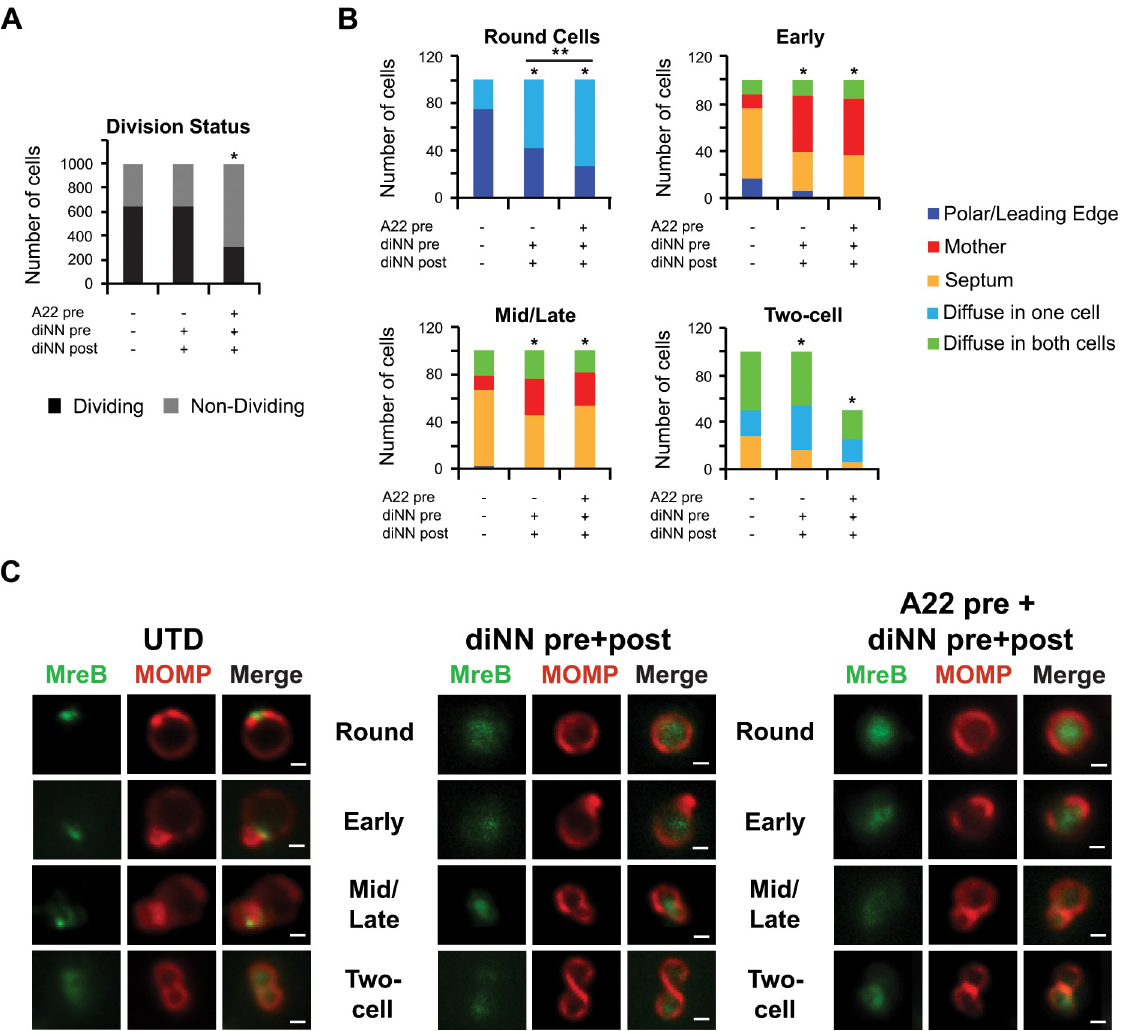
Fig 7. Effect of the CL-targeting antibiotic 3’,6-dinonylneamine (diNN) and the MreB-targeting antibiotic A22 on localization of MreB_6xH. HeLa cells were infected with the MreB_6xH transformant, and, at 22hpi, infected cells were lysed and chlamydial cells in the lysate were induced by incubating the cells in axenic media containing 10nM aTc. In some instances, cells were preincubated with 5 μ M diNN or 5 μ M diNN + 75 μ M A22 for 30 minutes and then induced with aTc in the presence of 5 μ M diNN alone. Following induction, the localization of MreB_6xH at various stages of division was assessed by staining cells with MOMP and 6xHis antibodies. (A) The total number of dividing versus non-dividing cells from the indicated culture conditions was quantified from 1000 total bacteria. � = p < 0.0001 compared to the untreated (UTD) control as measured by chi-squared test. (B) The localization of MreB_6xH was assessed in individual cells from each stage of division from untreated cultures or cultures treated as indicated in the figure. Localization profiles were categorized into leading edge of the budding daughter cell/polar, diffuse in mother cell, diffuse in one cell, diffuse in both cells, or septum. The differences in localization of MreB_6xH between treatment conditions at each stage of division were statistically analyzed using a chi-squared test to reveal that the changes resulting from drug treatments were statistically significant when compared to UTD ( � = p < 0.0001). Pretreatment of cells with diNN and A22 resulted in a statistically significant difference in MreB localization in pre-division intermediates (round cells) when compared to pretreatment with diNN alone ( �� = p < 0.02). For (A) and (B), data were pooled from two independent experiments. (C) Representative images illustrating the distribution of MreB_6xH (labeled MreB) at different stages of division in untreated cells or in cells treated with drugs as indicated in the figure. Scalebar = 2 μ